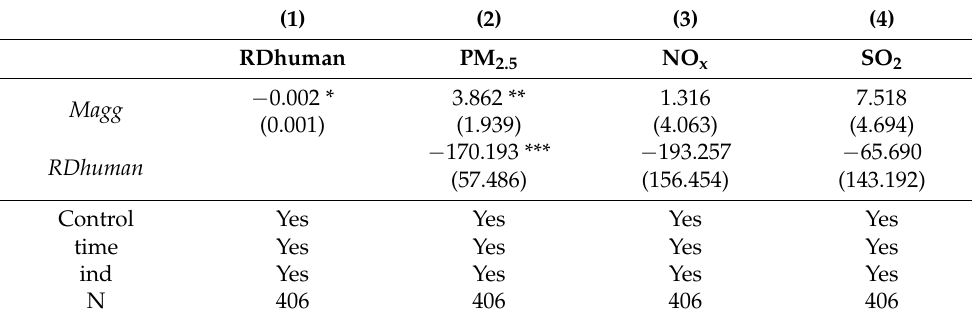
Table 15. Test of the mediating role of human capital in the agglomeration of manufacturing.